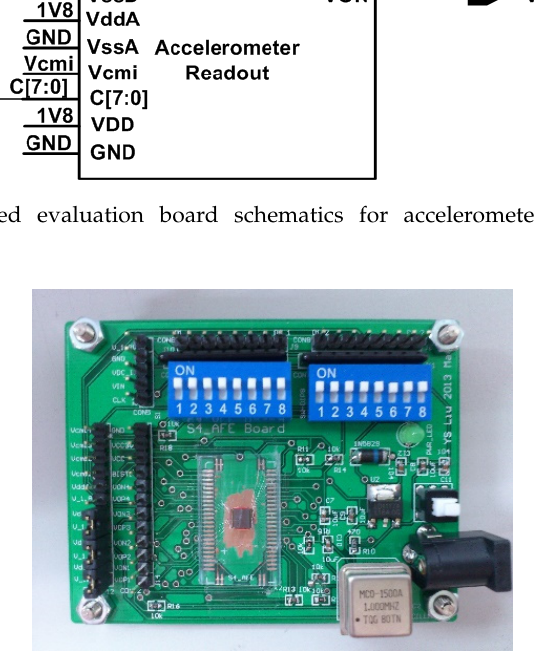
Figure 11. Evaluation board photo.